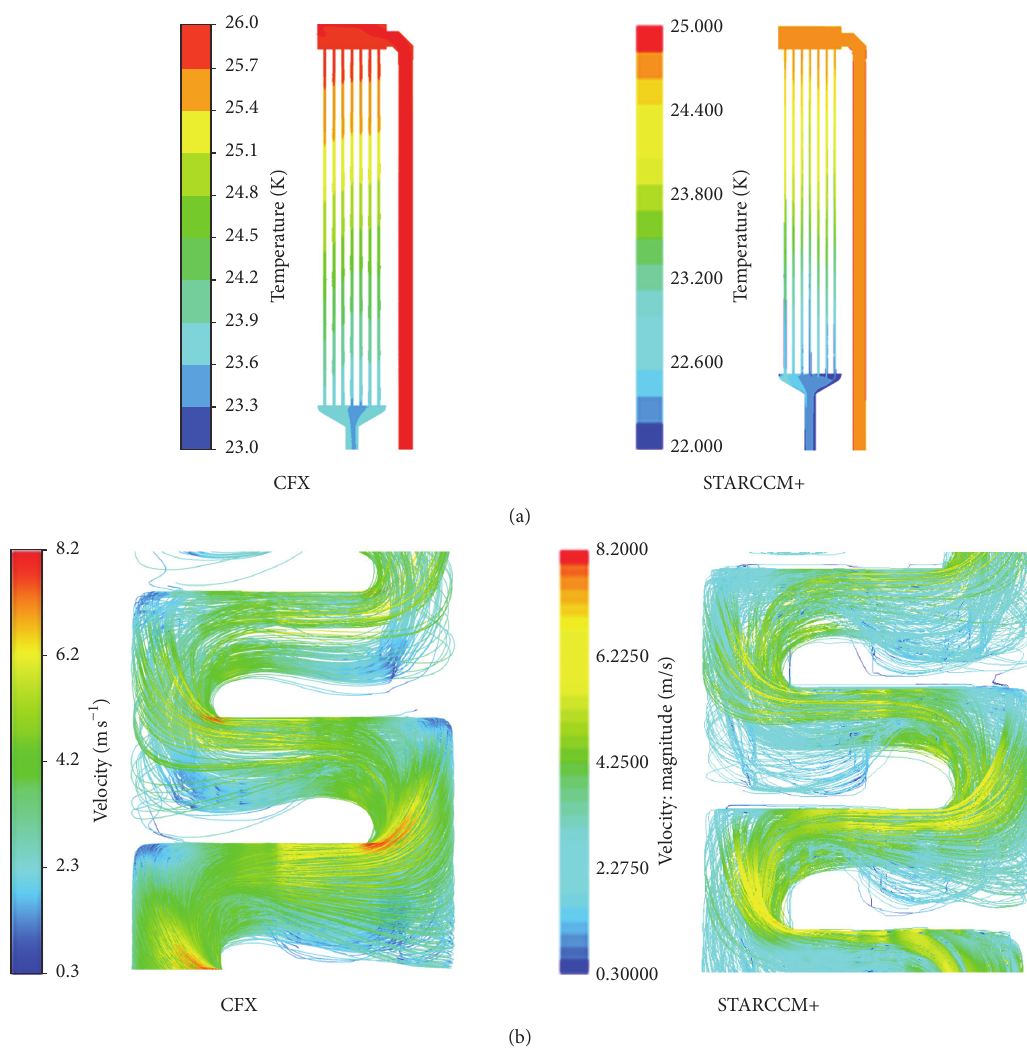
Figure 6: (a) The temperature field in the hot-leg and heat exchanger, (b) streamlines and velocity traces in the heat exchanger baffle, as calculated by CFX and